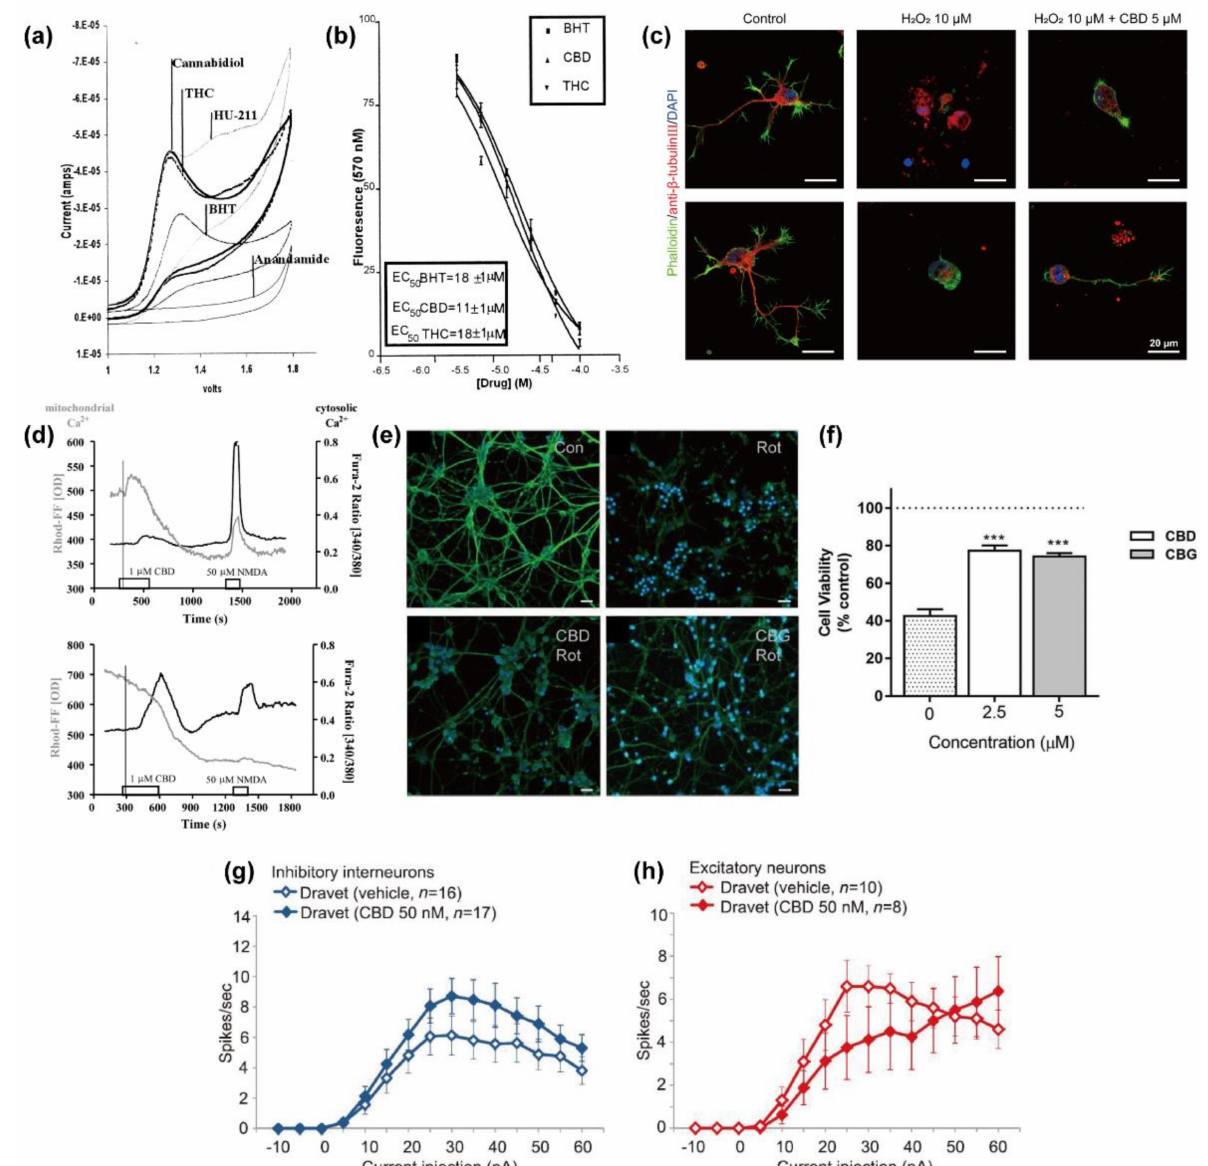
Figure 3. CBD actions on neurons. ( a ) A comparison of the oxidation potentials of cannabinoids and the antioxidant BHT. ( b ) Effects of CBD and BHT on prevention of tert -butyl hydroperoxide-induced oxidation of dihydrorhodamine. ( a , b ) Reproduced with permission from [23]. Copyright 1998, National Academy of Sciences, U.S.A. ( c ) High-magnification CLSM images of hippocampal neurons after 24 h treatment of ( middle ) H 2 O 2 (10 µ M), ( right ) H 2 O 2 (10 µ M), and CBD (5 µ M). The cells were stained green (F-actin), red ( β -tubulin III), and blue (nuclei). Reproduced from [24]. ( d ) Effects of CBD (1 µ M) on mitochondrial and cytosolic Ca 2+ responses of hippocampal neuron cultures, loaded with Rhod-FF, AM, and fura- 2 AM. Reproduced with permission from [25]. Copyright 2009, Society for Neuroscience. ( e ) Immunocytochemistry images of the CGNs pre-treated with CBD (2.5 µ M; 1 h) or CBG (5 µ M; 1 h) and exposed to rotenone. The cells were stained with Hoechst 33258 dye (blue; nuclei) and the cytoskeleton marker anti- α -tubulin (green). Scale bar: 20 µ m. ( f ) Neuroprotective effects of CBD (1 h pre-treatment) against rotenone. The statistical analysis was performed using one-way ANOVA; *** p < 0.001 for CBD (2.5 µ M) and CBG (5 µ M) versus rotenone exposure. ( e , f ) Reproduced with permission from